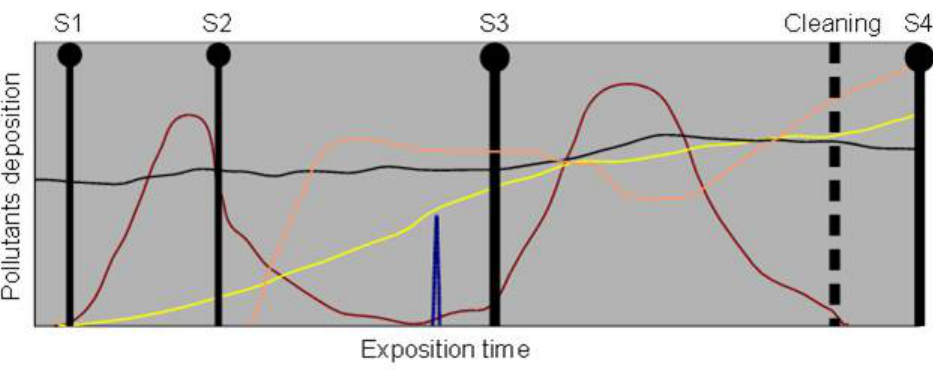
Figure 2. Simplified representation of pollutants deposition on a surface of the built environment. Four moments of sampling are considered. Under undisturbed conditions (S1-3) earlier sampling corresponds to more specific pollution conditions. In S4 only the pollutants deposited after cleaning are assessed, (admitting the success of the cleaning procedures and that no residue of cleaning substances remains). Prepared with OpenOffice